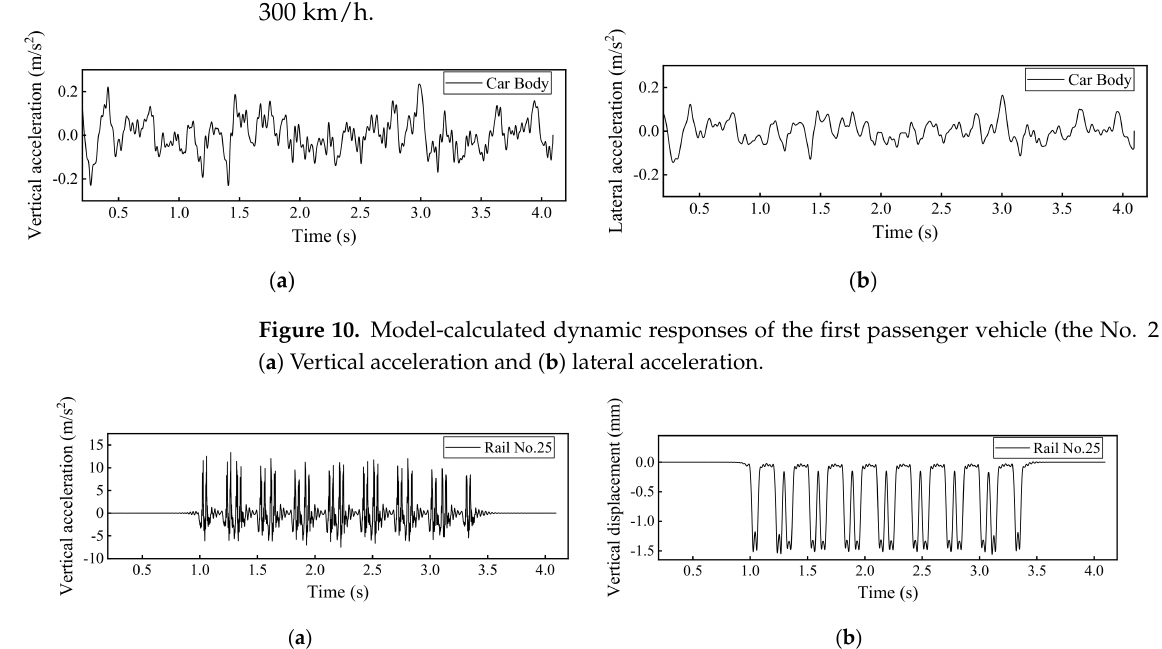
Figure 11. Model-calculated dynamic responses of the No. 25 rail: ( a ) Vertical acceleration and ( b ) vertical